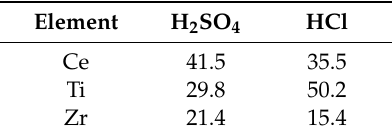
Figure 8. Extraction of titanium, zirconium and cerium from zirconolite in alkaline media at 70 °C.